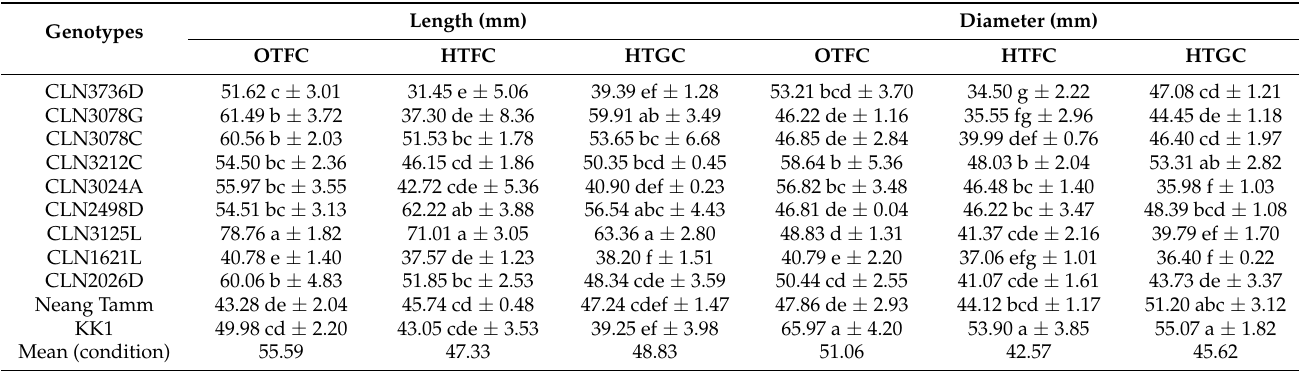
Table 2. Fruit length and fruit diameter of tomato genotypes under optimal temperature field condition (OTFC), high temperature field condition (HTFC), and high temperature greenhouse condition (HTGC).